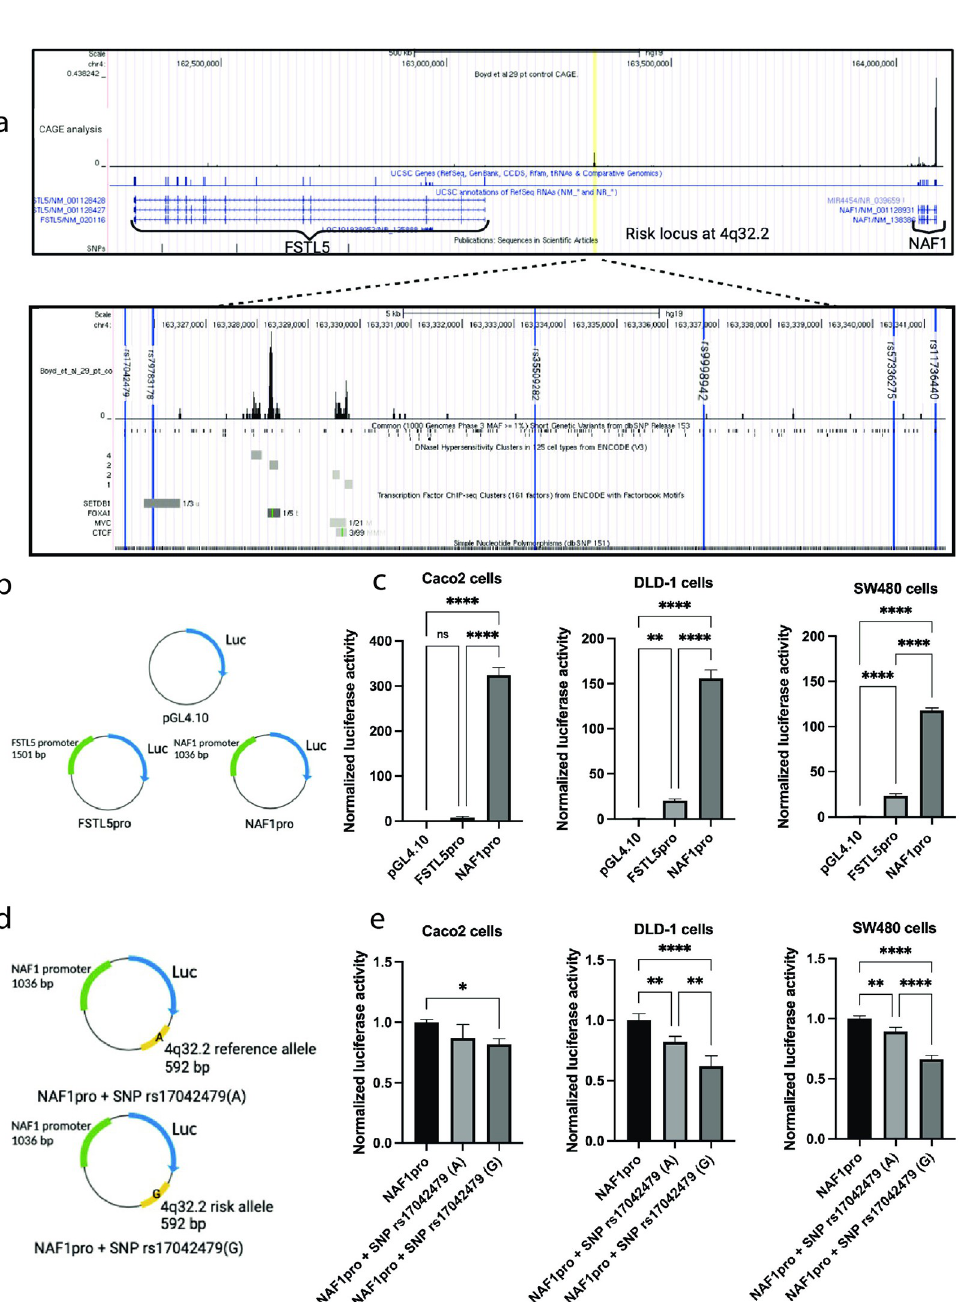
Fig 1. (a) Location of the risk locus at 4q32.2. CAGE analysis [14] of the region containing the two genes NAF1 and FSTL5 and the risk locus at 4q32.2, shown in yellow, are presented in the top [16]. The bottom presents a zoom in of the risk locus at 4q32.2, that shows the 6 SNPs found in Schmit et al ., highlighted in blue. From left: rs17042479 (A/G), rs79783178 (-/AT), rs35509282 (A/T), rs11736440 (A/G), rs9998942 (C/T) and rs57336275 (C/T) (b) Plasmid map of the construct used in the promoter reporter gene assay of promoter activity (c) Promoter reporter assay. Promoter activity of FSTL5 (FSTL5pro) and NAF1 (NAF1pro) in colon cancer cell lines. From left to right: Caco2 cells, DLD-1 cells and SW480 cells. Luciferase activities were corrected for transfection efficiency and normalized to the activity of the pGL4.10 without promoter (pGL4.10). N = 4. Statistical significance was determined using one-way ANOVA. (d) Plasmid map of the construct used in the promoter reporter gene assay of the gene regulatory region (e) Promoter reporter assay. The luciferase activities were corrected for transfection efficiency and normalized according to the expression of the NAF1 promoter (NAF1pro). From left to right: Caco2 cells, DLD-1 cells and SW480 cells. NAF1pro + SNP rs17042479(A) is the construct with the NAF1 promoter and the reference allele of SNP rs17042479. NAF1pro + SNP rs17042479(G) is the construct with the NAF1 promoter and the risk allele of SNP rs17042479. N = 4. Statistical significance was determined using one-way